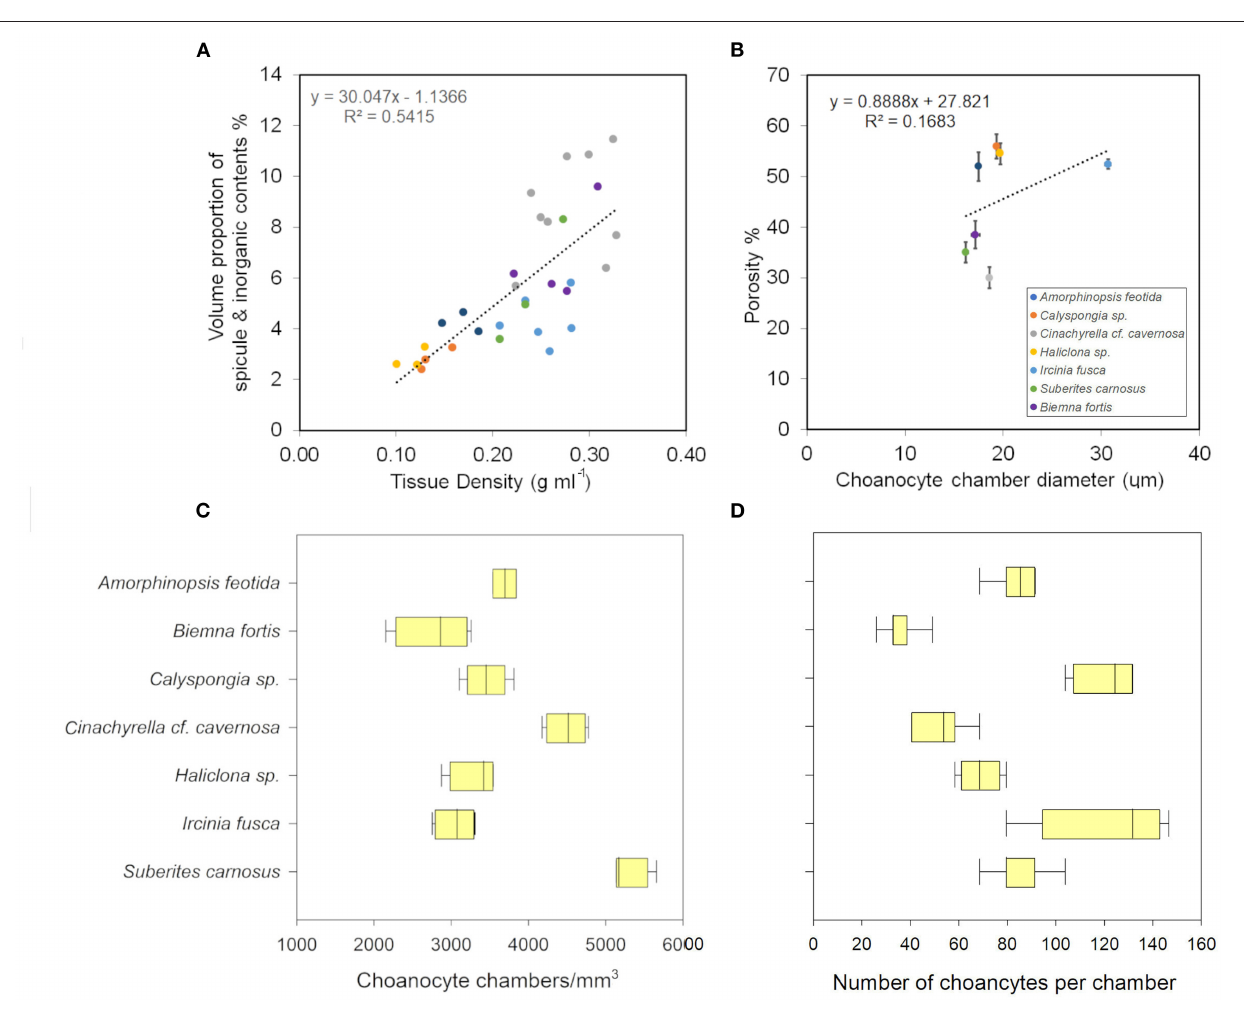
FIGURE 5 | (A) Volume of sponge tissue occupied by spicules (%) increases as the tissue density increases. (B) Porosity and the choanocyte chamber diameter show a positive relationship. (C) The choanocyte chamber abundance in different sponges. (D) The number of choanocytes per chamber in different sponges.